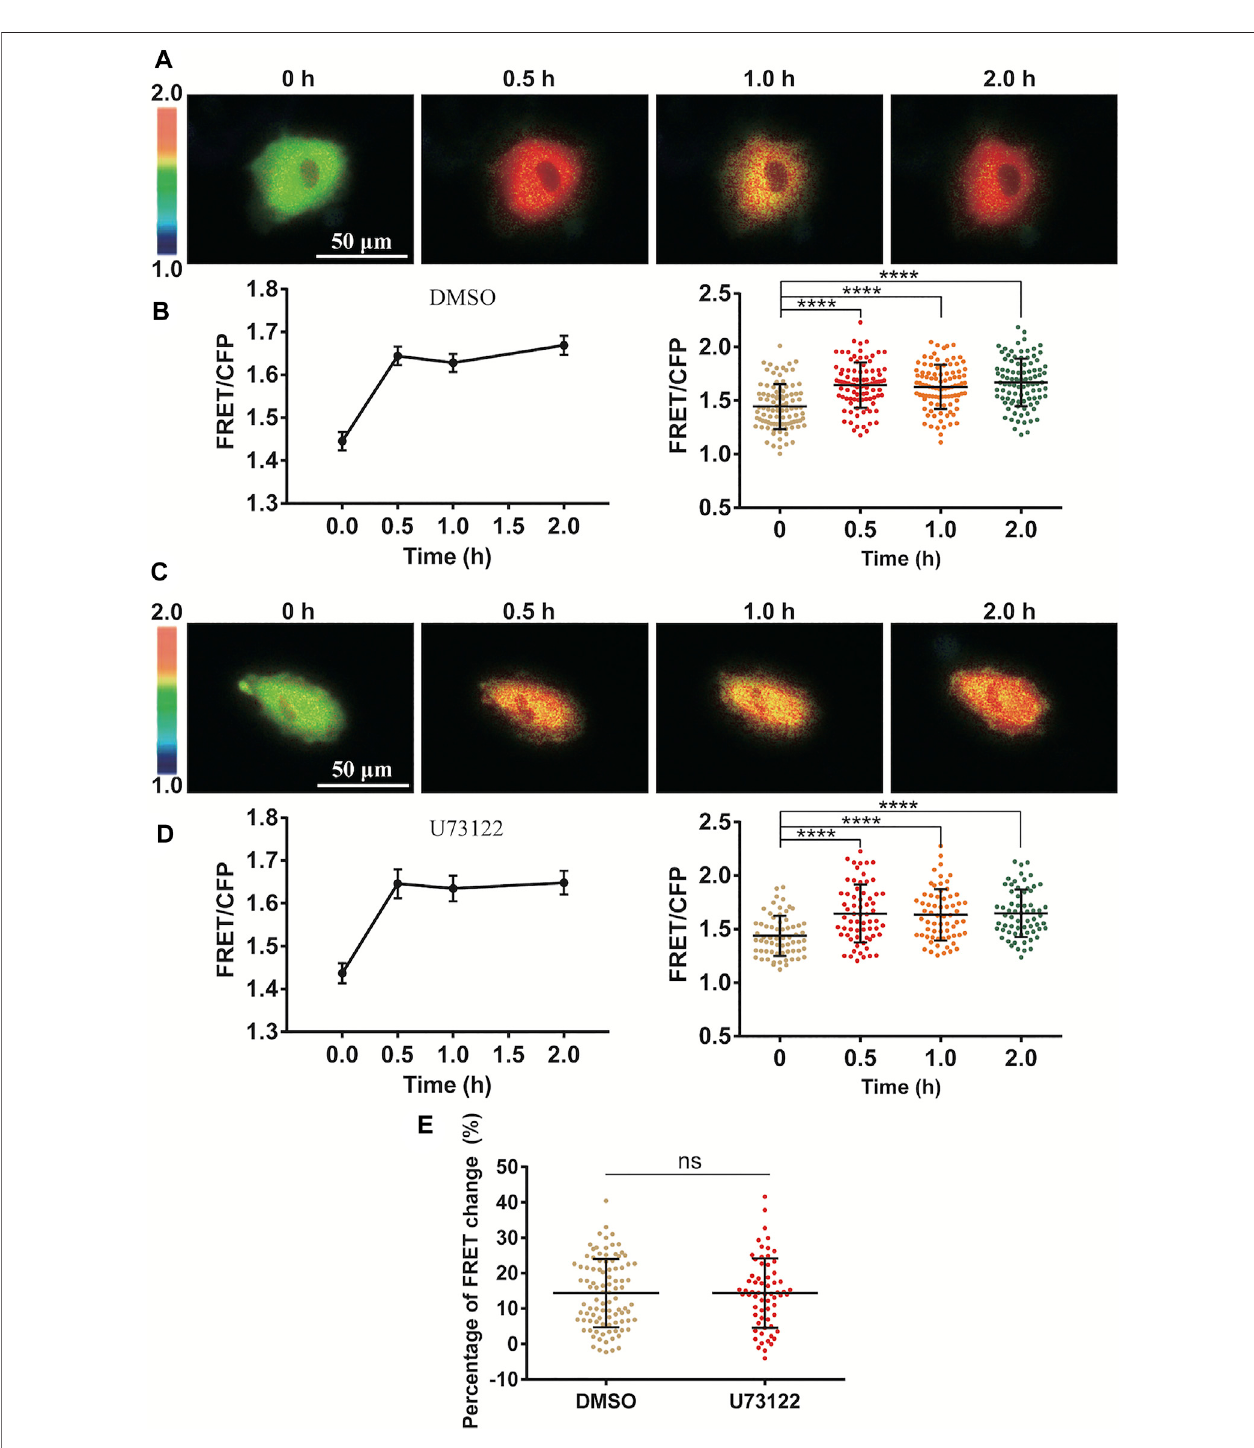
FIGURE 4 | Independence of PLC-IP 3 signal for cyclic stretch-induced ERK activation. ASM cells were pretreated with PLC inhibitor U73122 (10 µM) for 1.5 h followed by cyclic stretch. (A – D) FRET ratiometric images and quanti fi cation of FRET changes before and after cyclic stretch under the conditions of control (DMSO) (A,B) and U73122 treatment (C,D) . (E) Statistical comparison of FRET changes between the control ( n = 96) and U73122 ( n = 65) treatment after 0.5 h cyclic stretch, which is based on FRET data from three independent experiments. Student ’ s t-test was performed between the control and one experimental group.